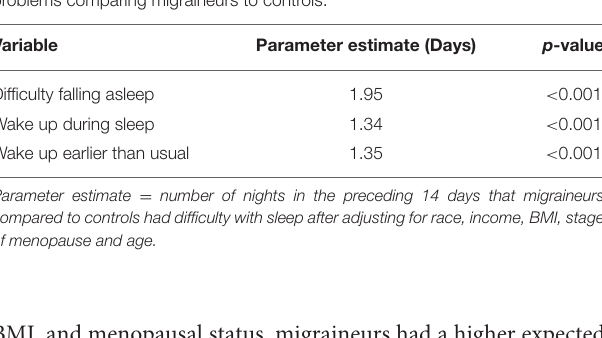
TABLE 3 | Poisson regression model of the number of nights with reported sleep problems comparing migraineurs to